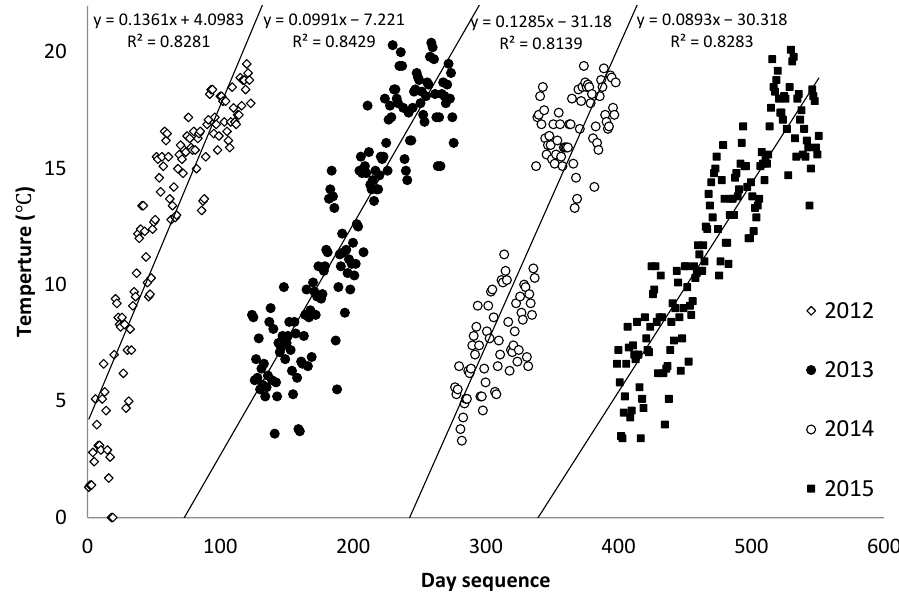
Figure 3. Grain size characteristics of samples from typical debris flow gullies in field investiga- tion.